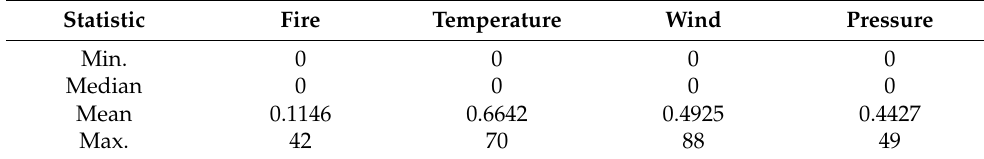
Table 1. Descriptive statistics of four keywords.